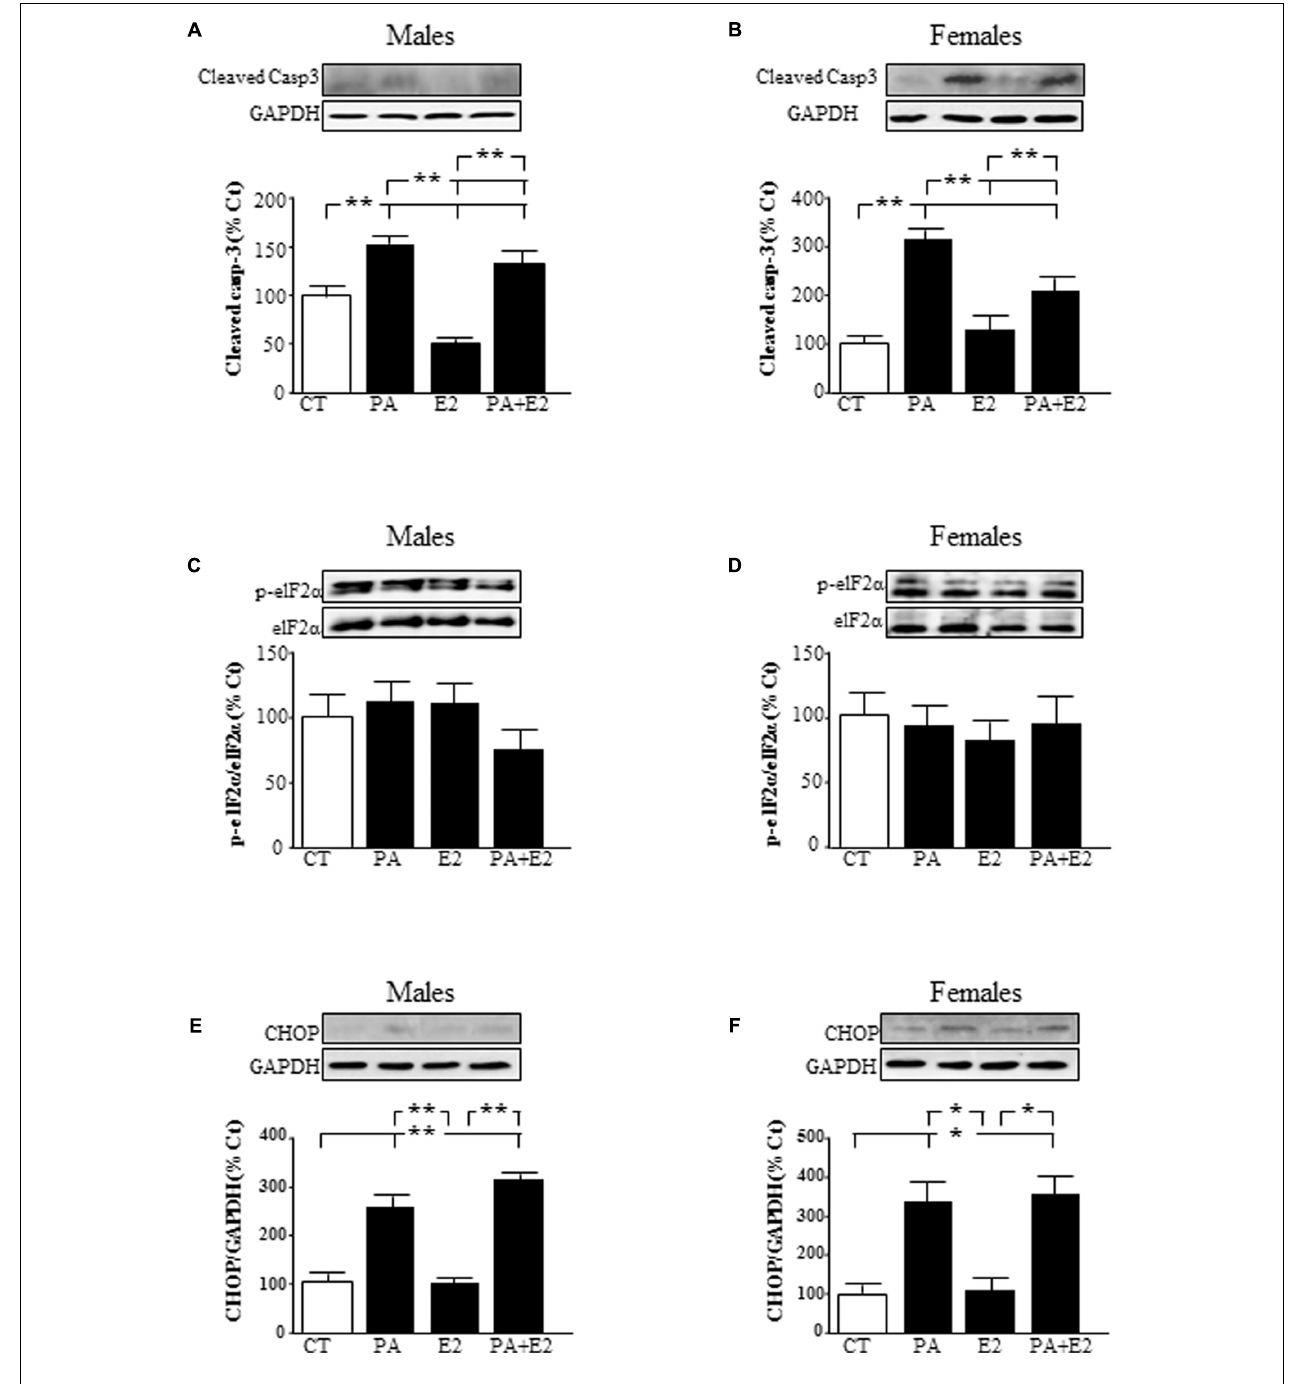
FIGURE 8 | Effects of PA and 17 β E2 on endoplasmic reticulum stress protein levels. Astrocyte cultures were treated with PA (0.5 mM), E2 (10 − 10 M), or the combination of both. Immunoblots were probed with antibodies toward cleaved caspase-3 levels (cleaved casp-3) in male (A) and female cultures (B) ; phospho-eukaryotic initiation factor (eIF)2 α and eIF2 α in males (C) and females (D) and C/EBP homologous protein (CHOP) in males (E) and females (F) . The average of three independent assays performed in duplicate is shown. Statistical significance: ∗ p < 0.05 and ∗∗ p <